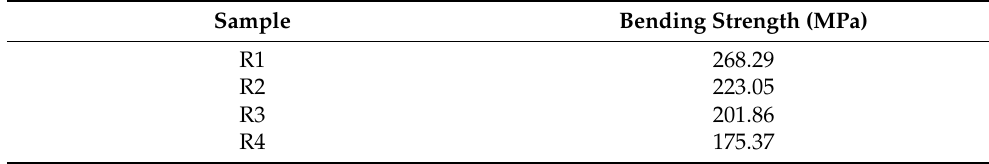
Table 3. Bending strength of R1–R4 at room